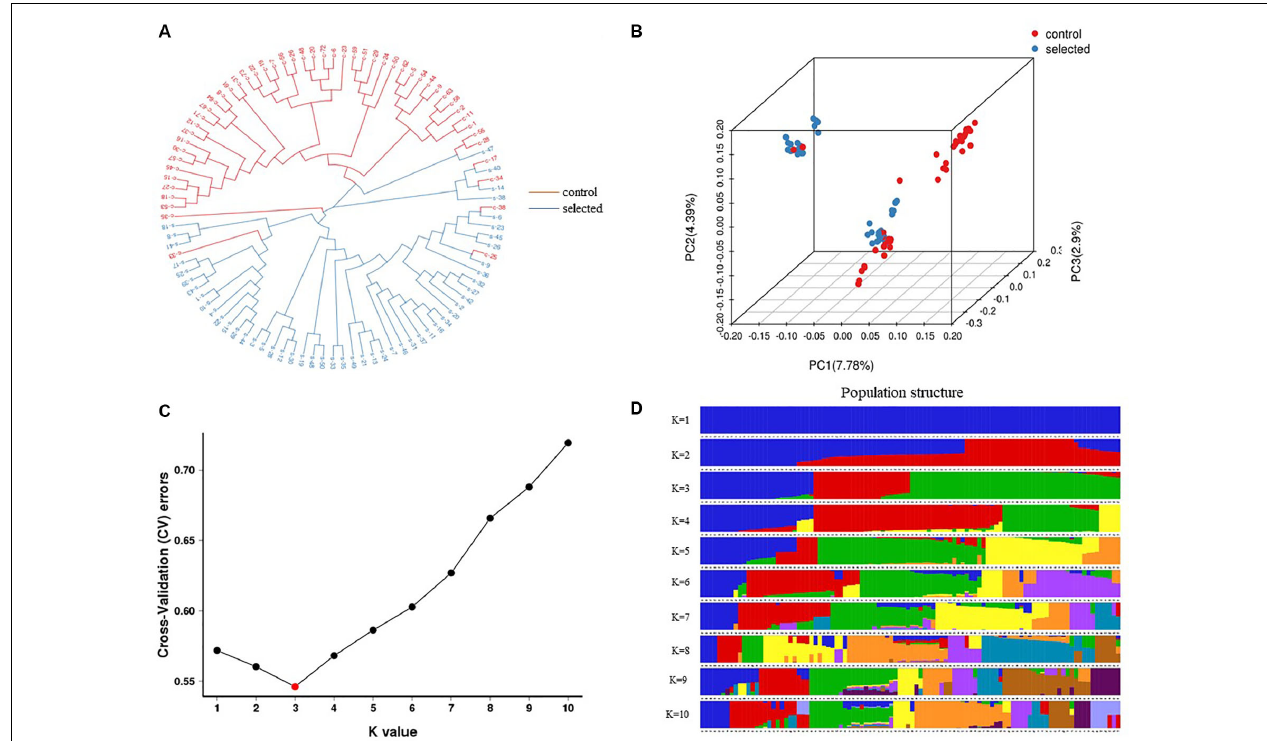
FIGURE 5 | Genetic structure analysis of 100 individuals which include 50 individuals from selected oysters and others from control oysters based on 379,002 SNPs. (A) The neighbor-joining phylogenetic tree divided into three clusters. (B) PCA plot showed three clusters. The red color represents control oysters and blue represents selected oysters in (A,B) . (C) Cross validation error rates corresponding to different K values show K = 3 is the best. (D) Population structure with a K -value of 3 and each color indicate one cluster.